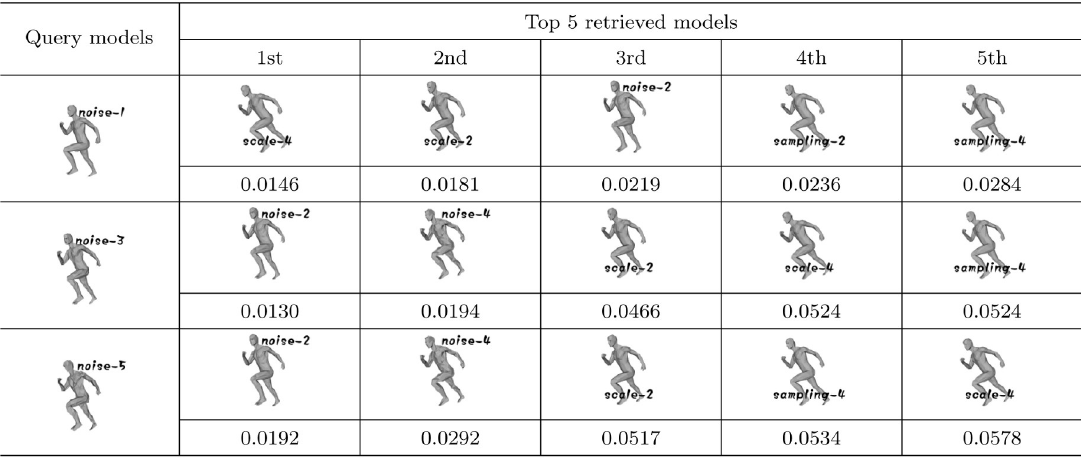
Table 4. The query results of robustness